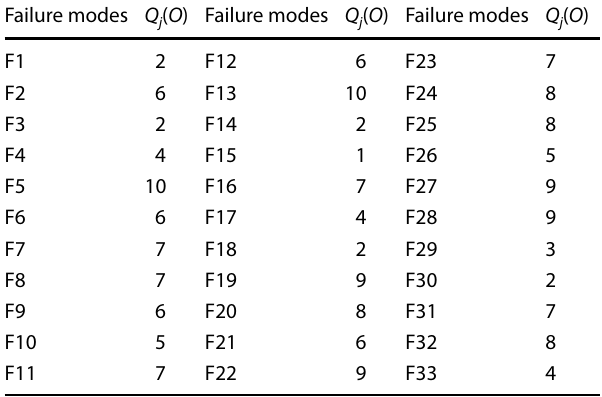
Table 6 Occurrence numbers for each failure mode